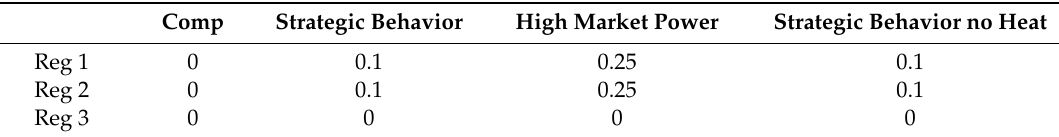
Table A1. Mark-up factors for gas regions. 0 means no market power and 1 means that the trader is a full Cournot player.